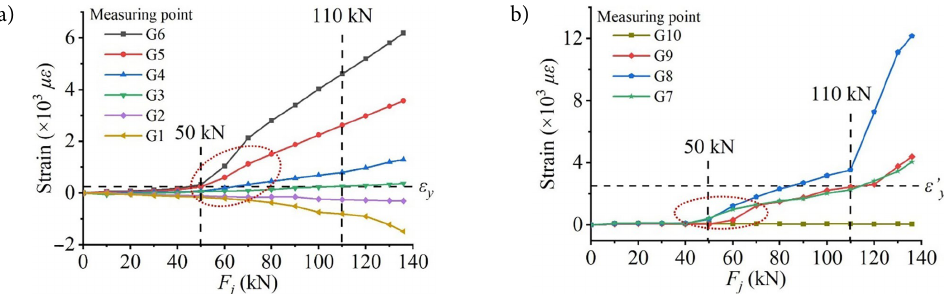
Figure 8. The S strain -F j curves of RC beam numbered BB5: a – The S strain - F j curves for the concrete and CRL; b – The S strain - F j curves for the longitudinal reinforcement and FRP grid